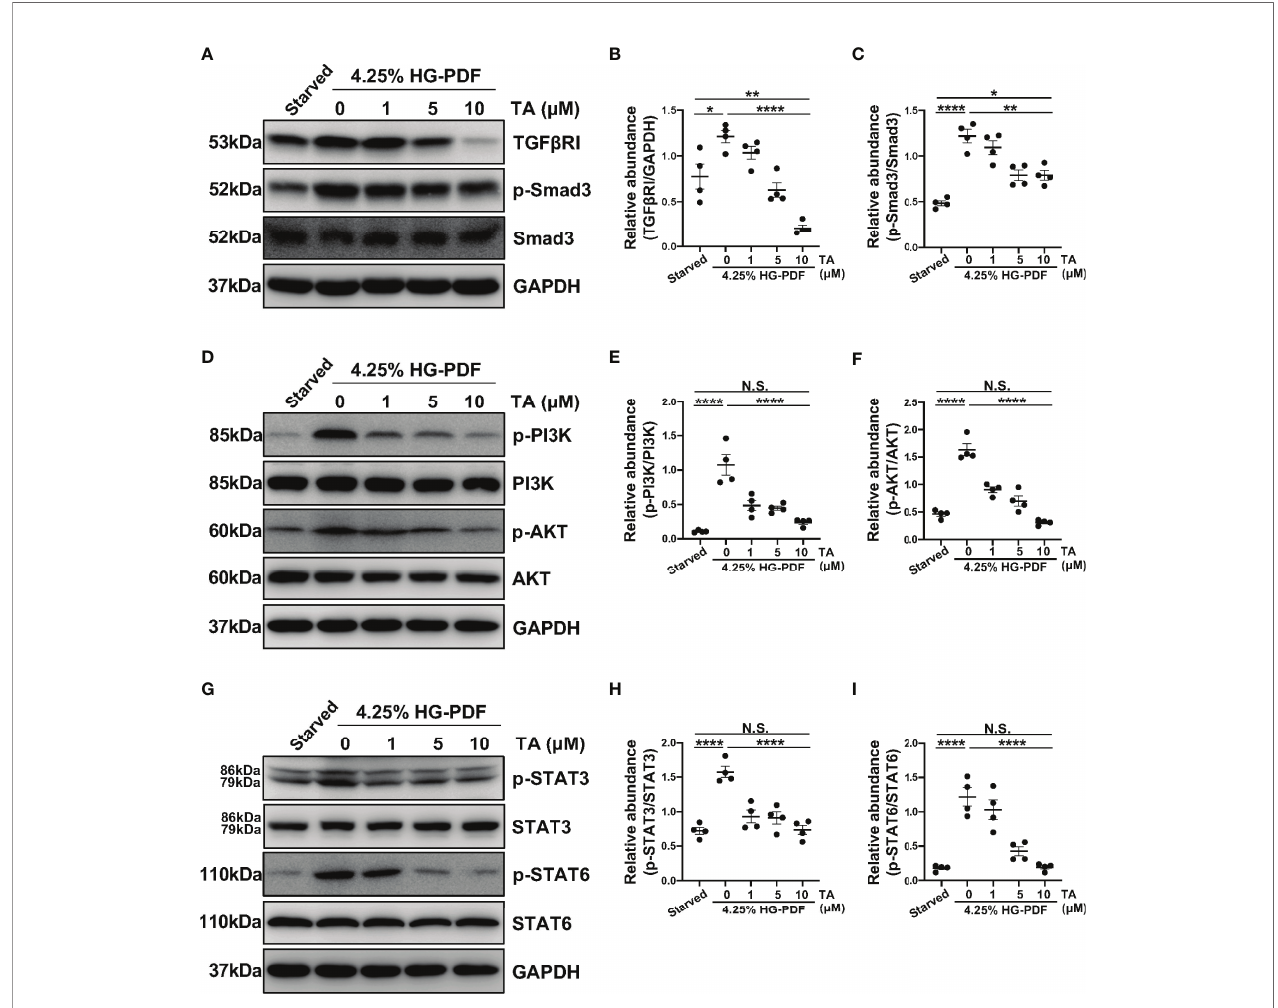
FIGURE 9 | TA inhibits M2 macrophage polarization via suppressing TGF- b 1/Smad3, PI3K/AKT, STAT3 and STAT6 signaling in Raw264.7 cells stimulated by HG-PDF. (A) Western blot analysis showed the levels of TGF b RI, p-Smad3, Smad3, and GAPDH in 4.25% HG-PDF treated Raw264.7 cells with different doses of TA. Expression levels of (B) TGF b RI and (C) p-Smad3 in different groups were quanti fi ed by densitometry and normalized with GAPDH and Smad3 respectively. (D) Western blot analysis showed the levels of p-PI3K, PI3K, p-AKT, AKT, and GAPDH in 4.25% HG-PDF treated Raw264.7 cells with different doses of TA. Expression levels of (E) p-PI3K and (F) p-AKT in different groups were quanti fi ed by densitometry and normalized with PI3K and AKT respectively. (G) Western blot analysis showed the levels of p-STAT3, STAT3, p-STAT6, STAT6, and GAPDH in 4.25% HG-PDF treated Raw264.7 cells with different doses of TA. Expression levels of (H) p-STAT3 and (I) p-STAT6 in different groups were quanti fi ed by densitometry and normalized with STAT3 and STAT6 respectively. Data were expressed as means ± SEM. *P<0.05, **P<0.01, ****P<0.0001. NS: P ≥